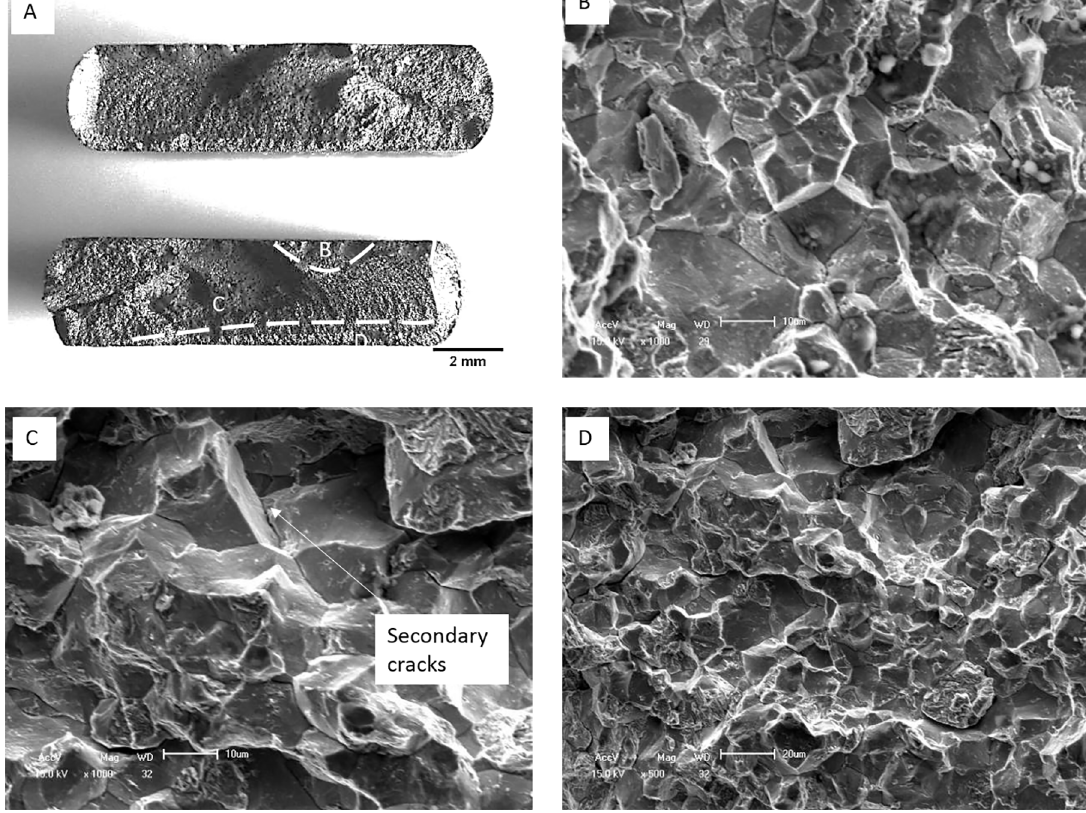
Figure 11. SEM analysis from martensitic material in environment with CP: (A) Overall fracture surface; (B) Initiation region; (C) Propagation region; and (D) Final fracture region. hydrogen is associated with an increasing in hydrogen solubility in the metal network structure reducing the cohesive force, i.e., interatomic bonds, and therefore promotes decohesion. The influence of stress results in a brittle fracture along the grain boundary, resulting in an intergranular fracture mode because of the decreased bonding strength 51 .